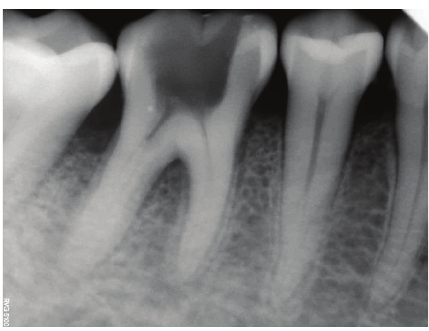
Figure 40: Radiograph showing the fracture of the cusp 36.